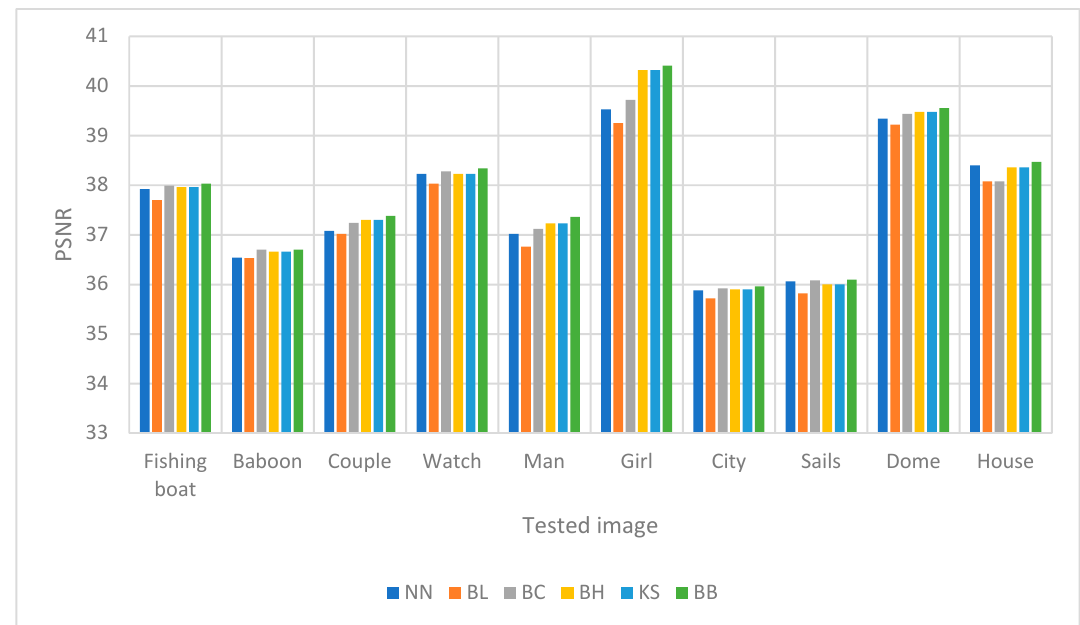
Figure 7. A comparison of schemes in regard to PSNR for image upscaling with a factor of two.